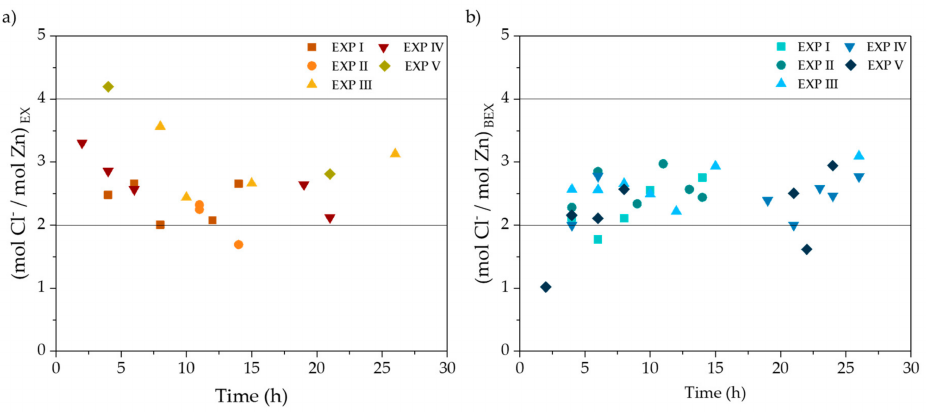
Figure 6. Molar ratio of chloride / zinc during the extraction ( a ) and backextraction ( b ) for EXP